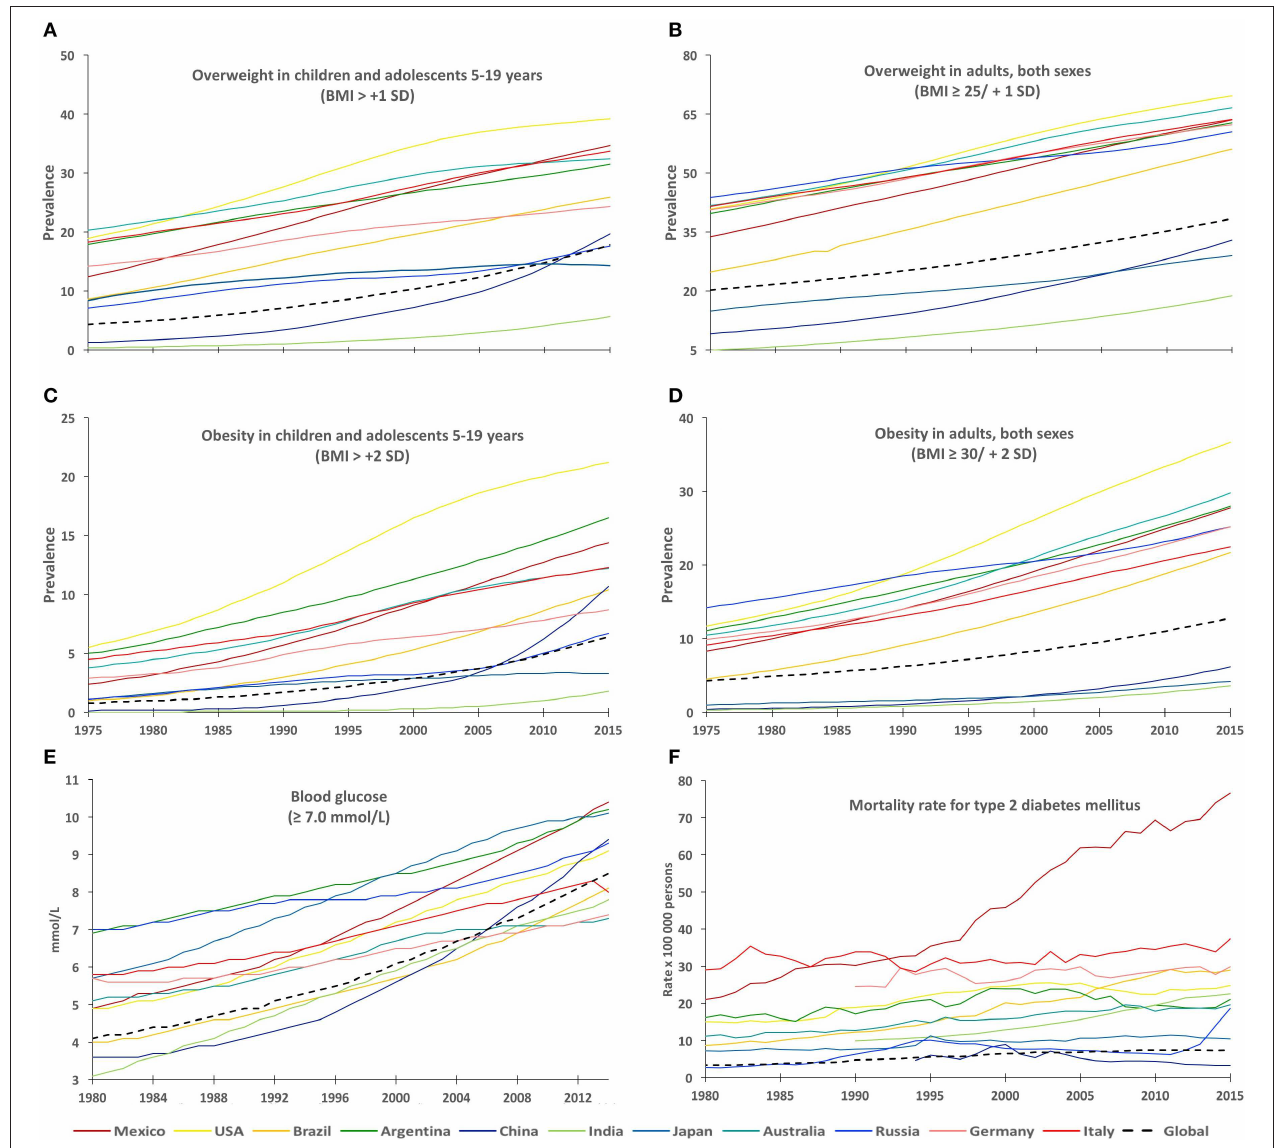
FIGURE 3 | Health variable behavior, over 35 years, for the 11 countries selected: prevalence of overweight in children/adolescents (A) and adults (B) ; prevalence of obesity in children/adolescents (C) and adults (D) ; (E) blood glucose levels; and (F) mortality rate due to type 2 diabetes mellitus.